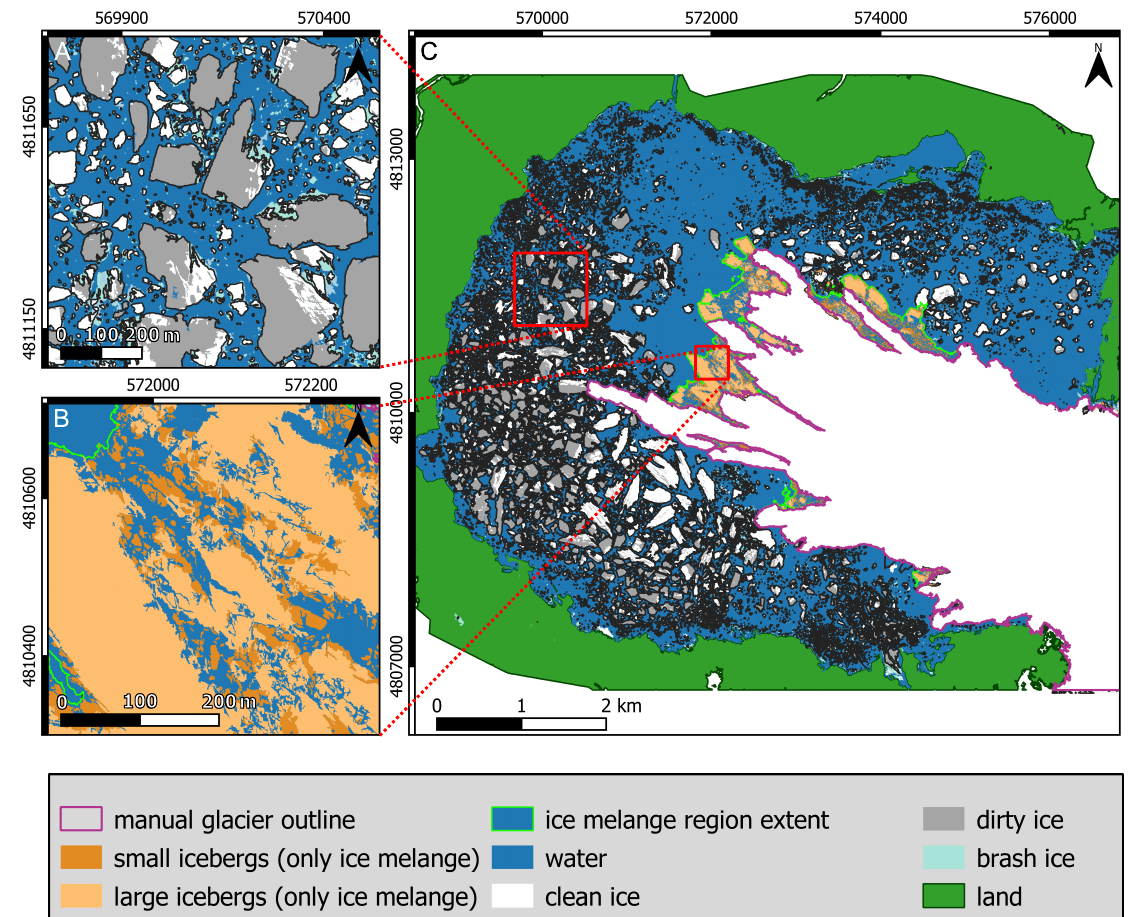
Figure 8. Final result of the iceberg map creation process: ( A ) example of iceberg map in the lagoon area; ( B ) example of iceberg map in the ice melange area; and ( C ) the overview of the classification over the whole lagoon and its surroundings. Coordinates in UTM 18S coordinate